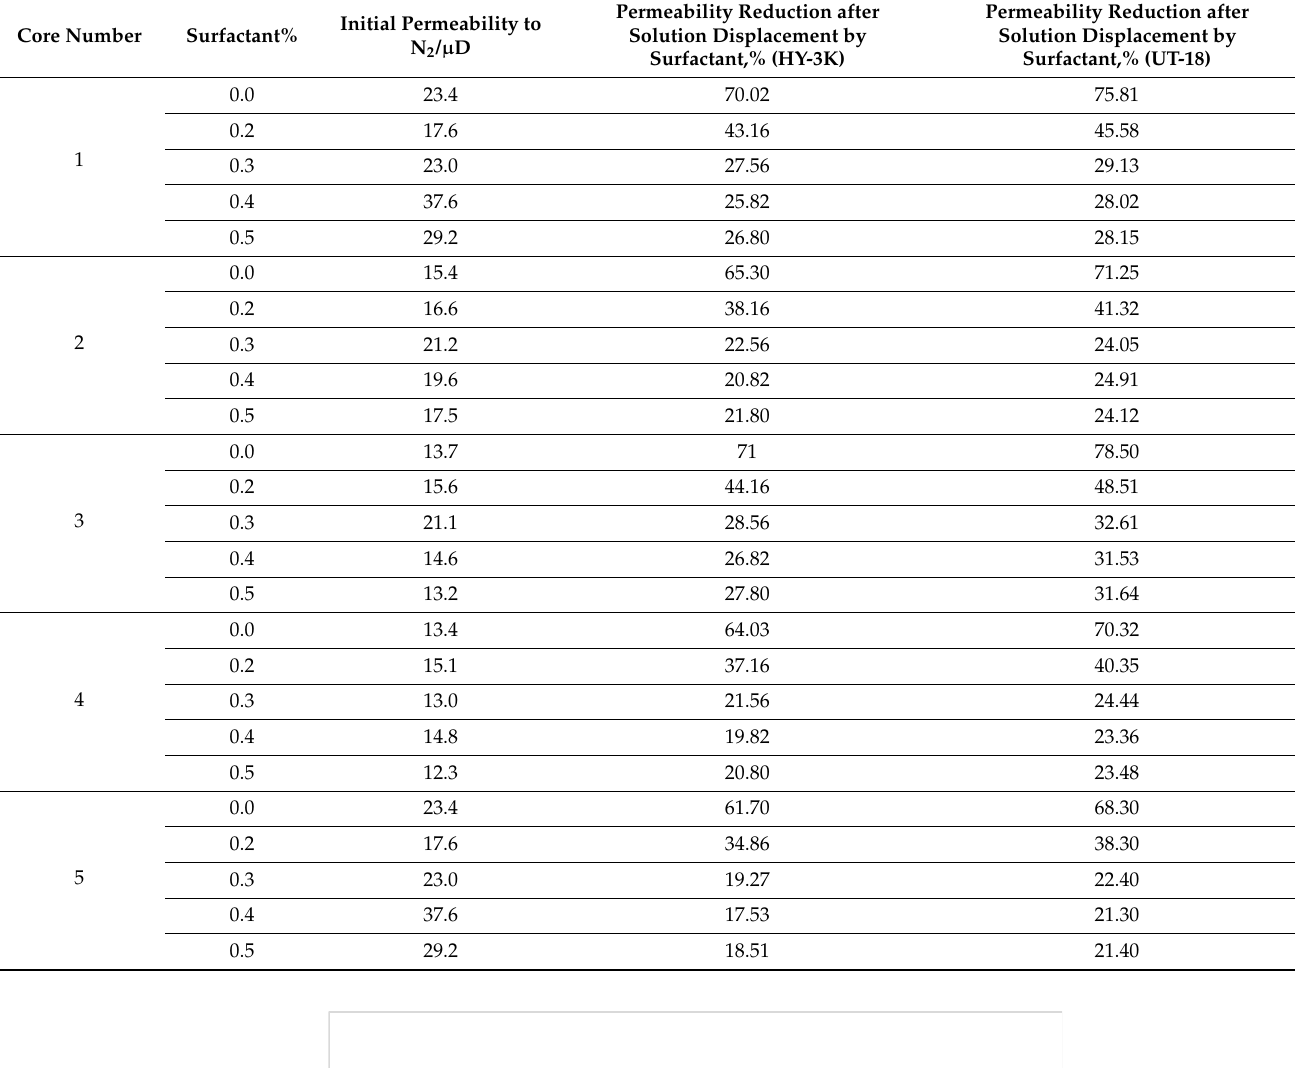
Table 5. Damage test of different concentrations of foaming agents to core permeability.